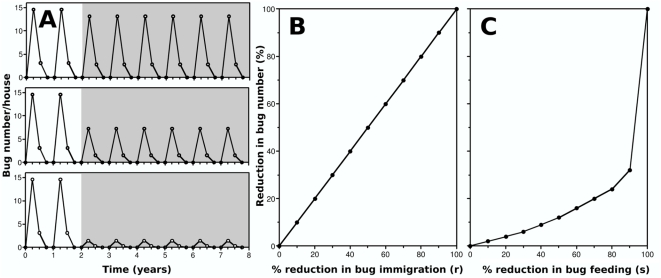
Evaluation of insect screens and bednets.(A) Variations in bug abundance with insect screens (gray shaded area) reducing bug immigration by 10 (top), 50 (middle), and 90% (bottom). (B,C) Efficacy of insect screens and bednets as a function of the percent reduction in bug immigration and bug feeding, respectively.